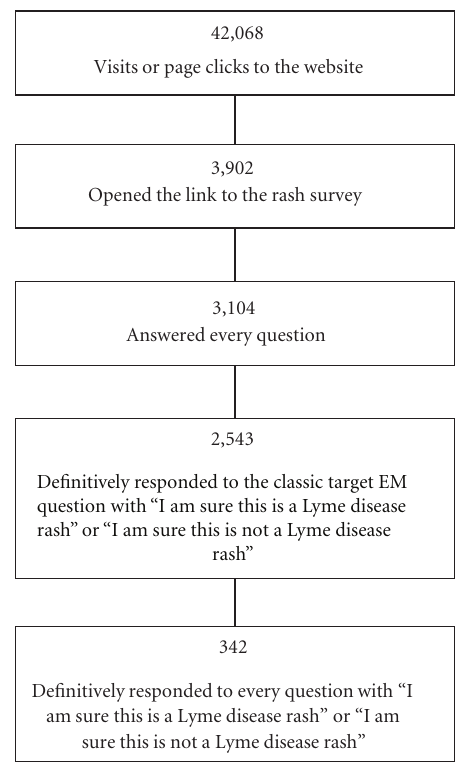
Figure 2: Number of responses at each stage of analysis.